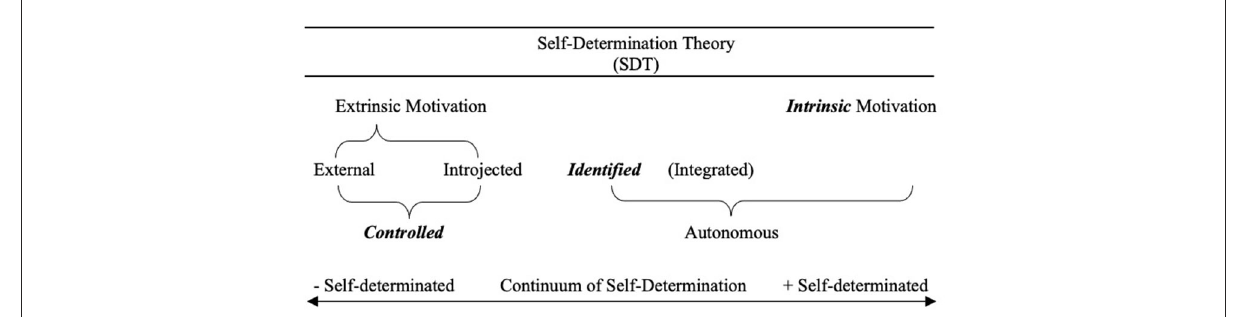
FIGURE1 Motivation in Self-Determination Theory (Ryan and Deci, 2017, 2019). Note. Following previous studies (Guay et al., 2010), the three types of motivation considered in this work to assess motivation at early ages are highlighted in bold italics: Intrinsic motivation and identified motivation as autonomous and external and introjected motivation as